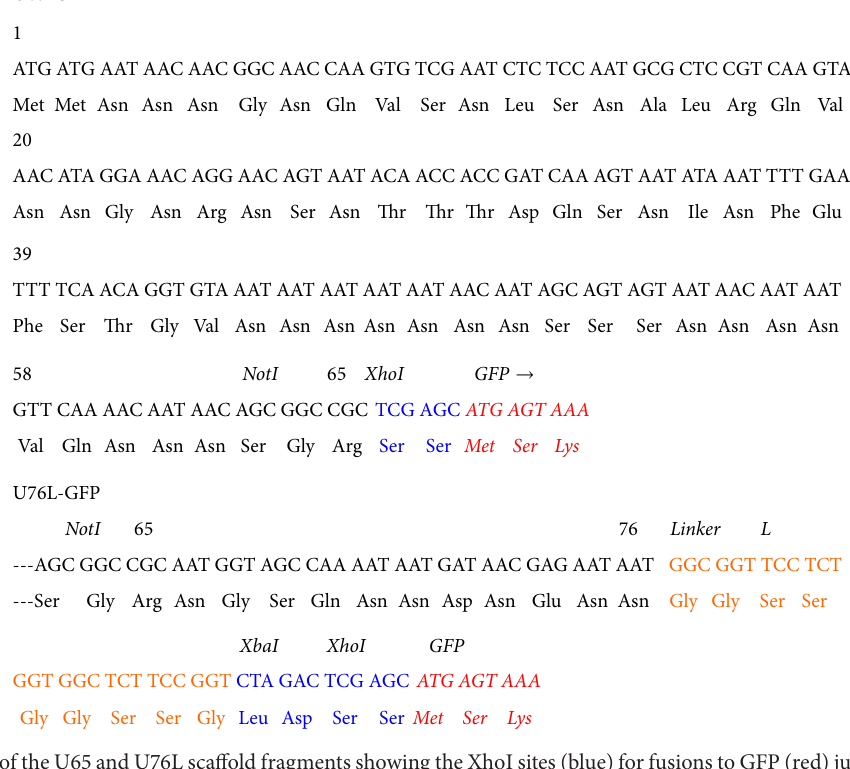
requires at least 10-fold higher copy number, potentially allowing a similar increase in plasmid-encoded